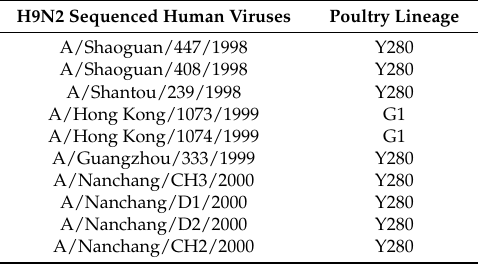
Table 2. Human H9N2